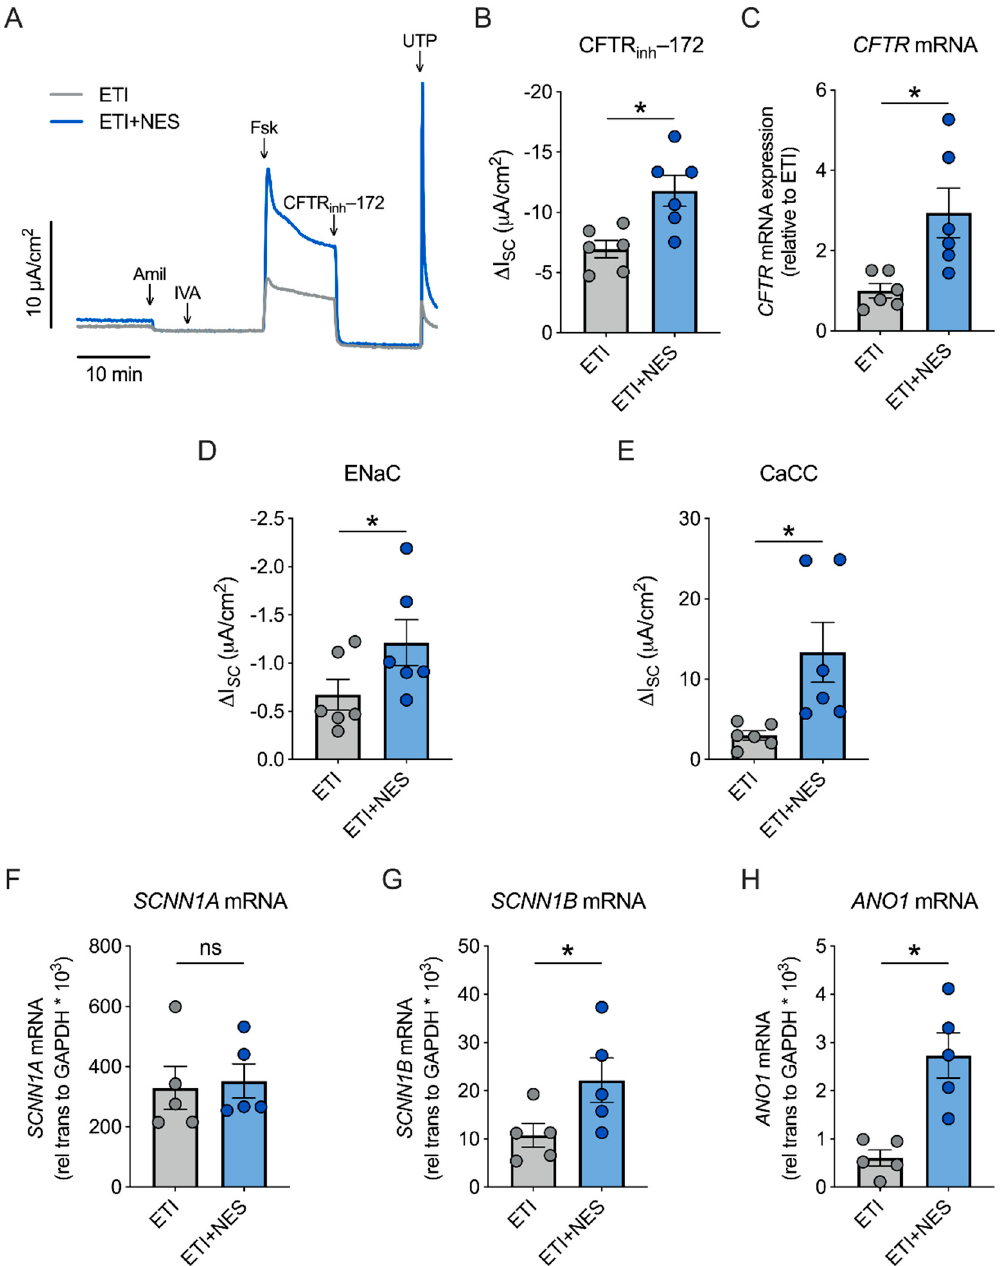
Figure 2. Nesolicaftor (NES) improves ETI-corrected F508del CFTR function in primary CFBE cells in vitro. ( A ) Fully differentiated ALI cultures of primary human CFBE cells homozygous for F508del were treated with elexacaftor (1 µM)/tezacaftor (5 µM)/ivacaftor (1 µM) (ETI) or ETI + NES (10 µM) for 24 h and CFTR-dependent I SC was measured in Ussing chambers. ( B ) Nesolicaftor significantly increases F508del CFTR function in ETI-treated CFBE cells after 24 h. n = 6, 3 CF lungs. ( C ) Nesolicaftor significantly increases expression levels of CFTR mRNA compared to ETI alone. n = 6, 3 CF lungs. ( D , E ) Amiloride-sensitive I SC (ENaC function) ( D ) and UTP-stimulated I SC (CaCC function) ( E ) are significantly increased by nesolicaftor in ETI-treated CFBE cells after 24 h. n = 6, 3 CF lungs. ( F , G ) Nesolicaftor significantly increases the expression of SCNN1B , but not SCNN1A , mRNA in ETI-treated CFBE cells after 24 h. n = 5, 3 CF lungs. ( H ) Nesolicaftor also causes a significant increase in the expression of ANO1 mRNA in ETI-treated CFBE cells after 24 h. n = 5, 3 CF lungs. Statistics: * p < 0.05, Student’s t -test after assessing normality with Shapiro-Wilk.